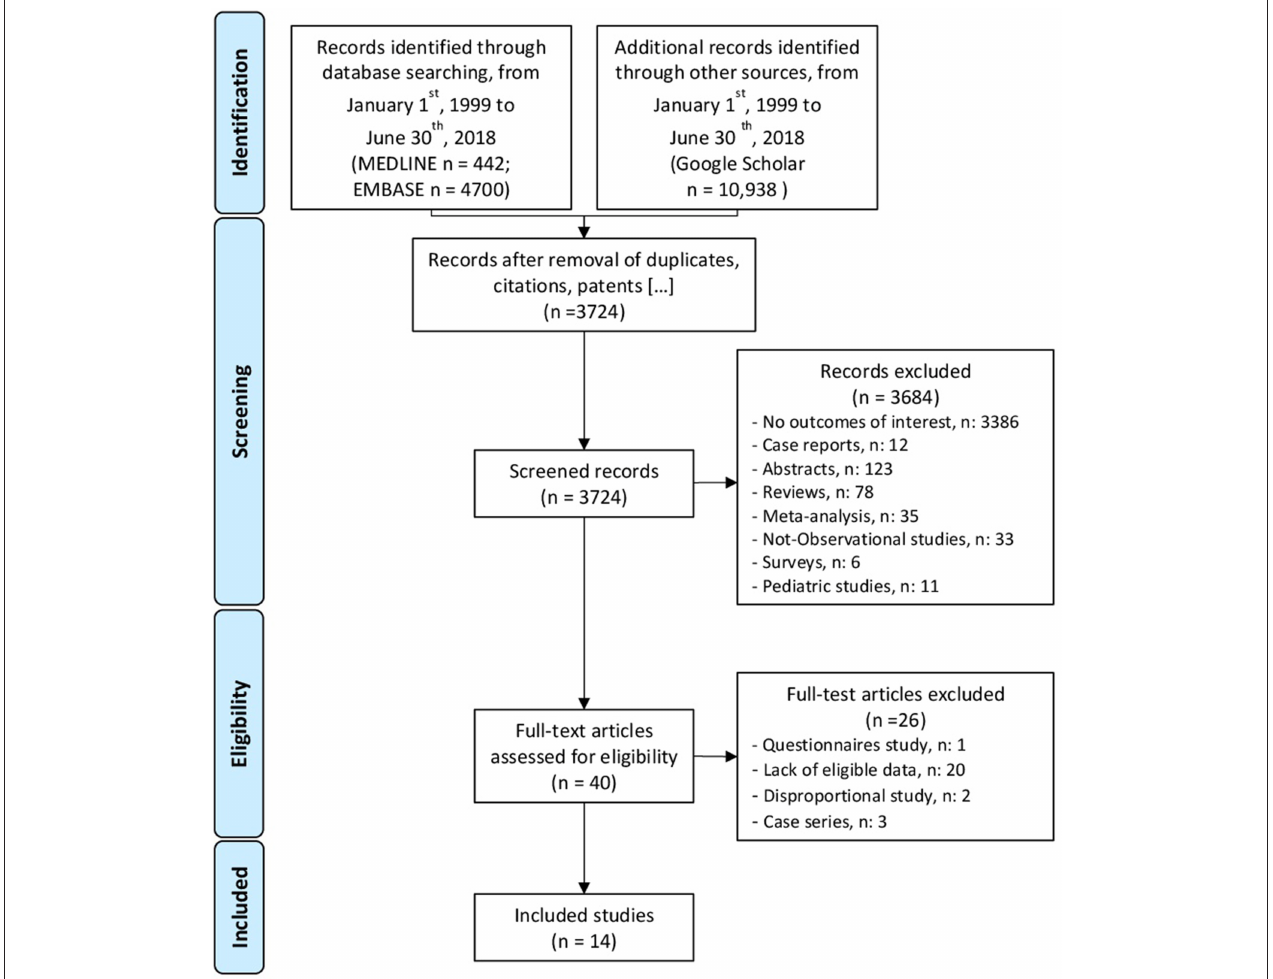
FIGURE 1 | PRISMA (Shamseer et al., 2015) flow chart of the search result of the analysis.